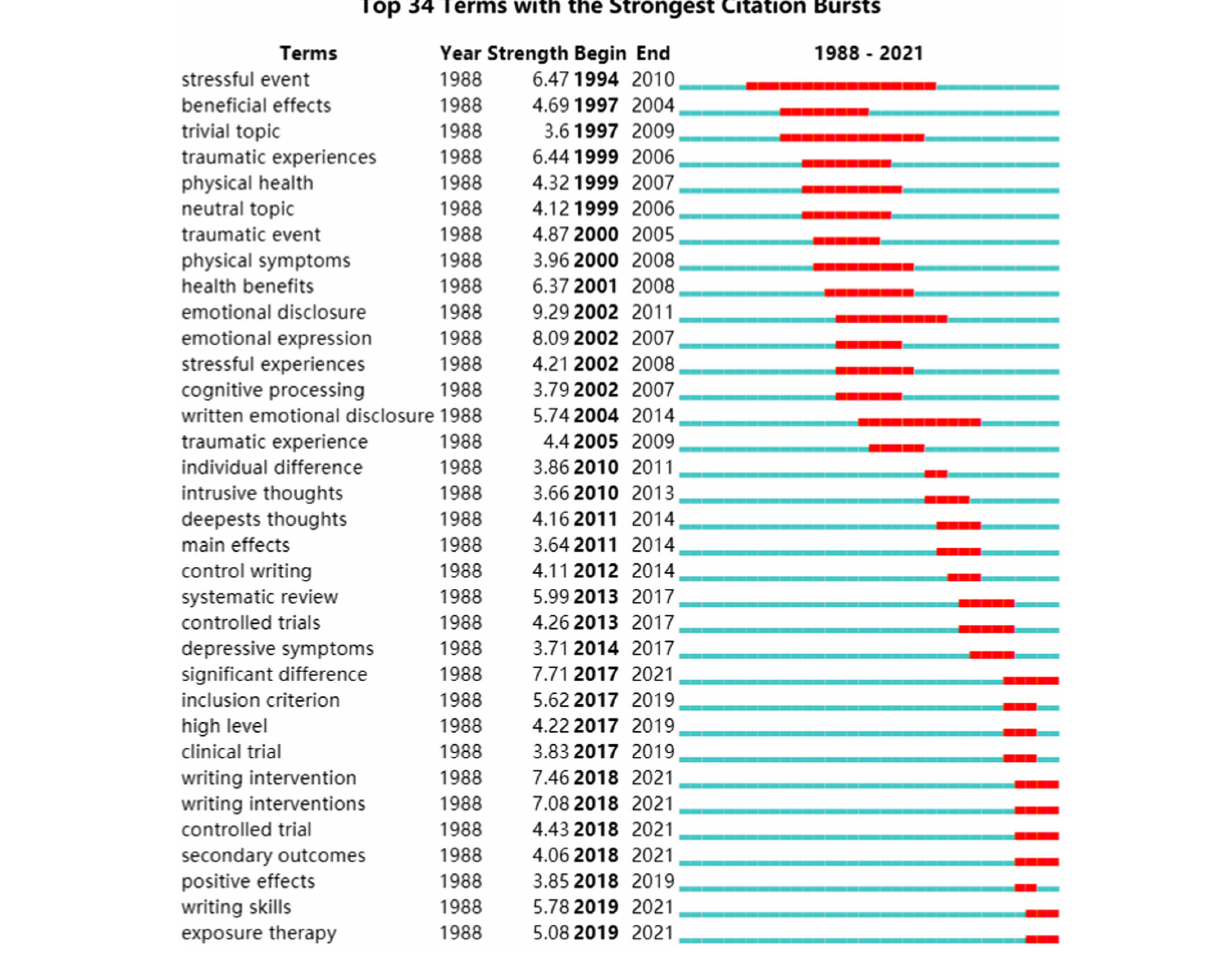
FIGURE 8 | Thematic evolution based on the top 34 terms with strongest citation bursts. Note: “Begin” and “End” suggest the period when activities such as publications or citations were most intense. Manually excluding the searching terms: expressive writing, writing intervention, emotional disclosure, expressive writing intervention, emotional expression, writing intervention, written emotional disclosure, writing therapy, expressive writing interventions, written disclosure, and written emotional